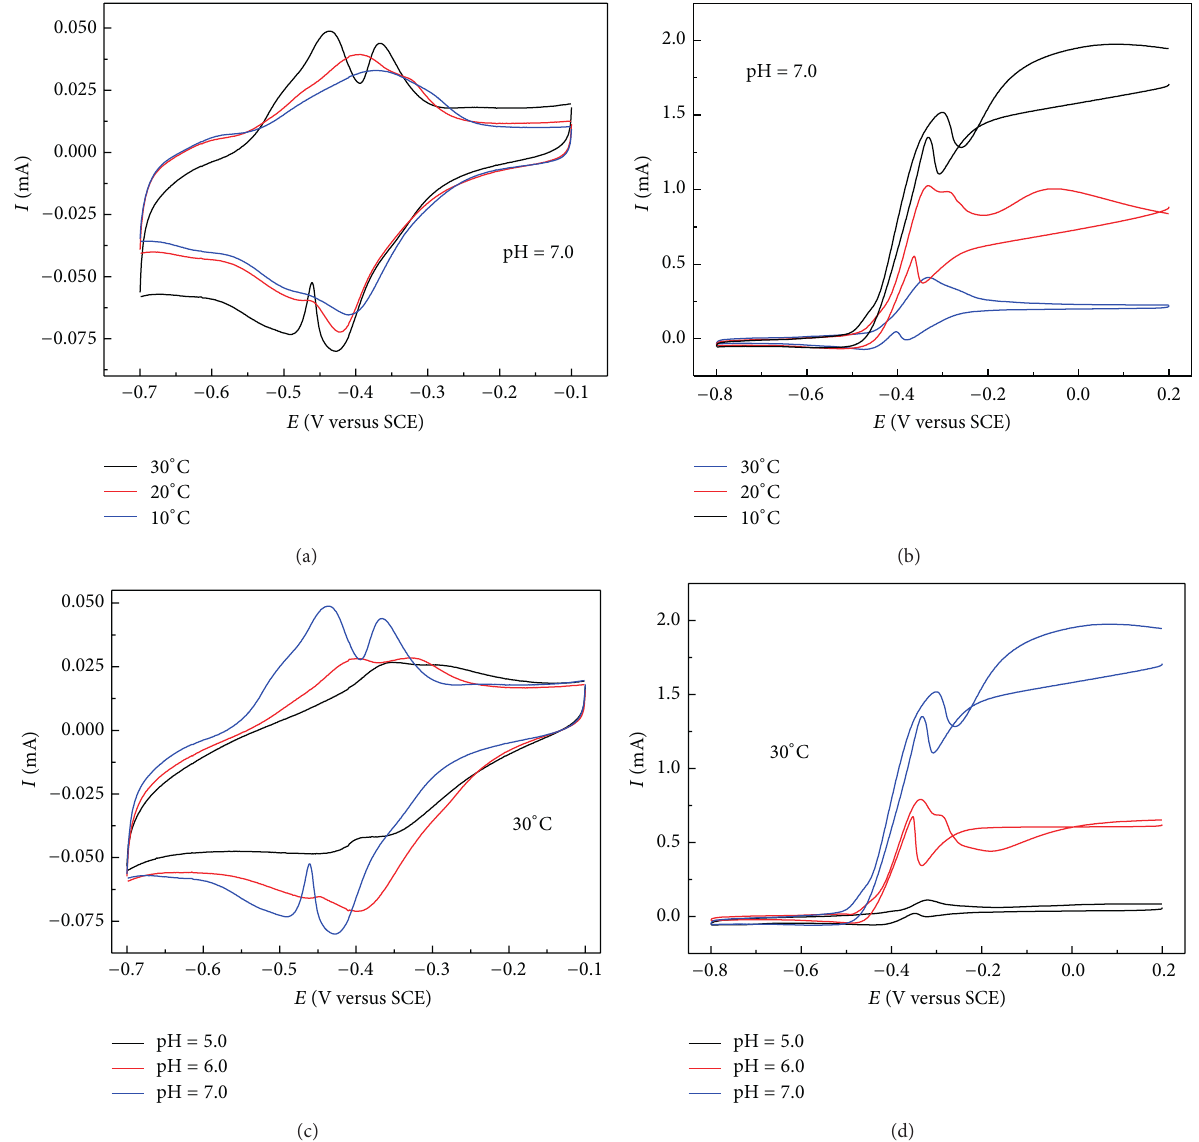
Figure 2: CVs of the anode biofilm under various temperatures by fixing pH condition under no-turnover state (a) and turnover state (b); CVs of the anode biofilm under various pH levels by fixing temperature condition under no-turnover state (c) and turnover state (d).